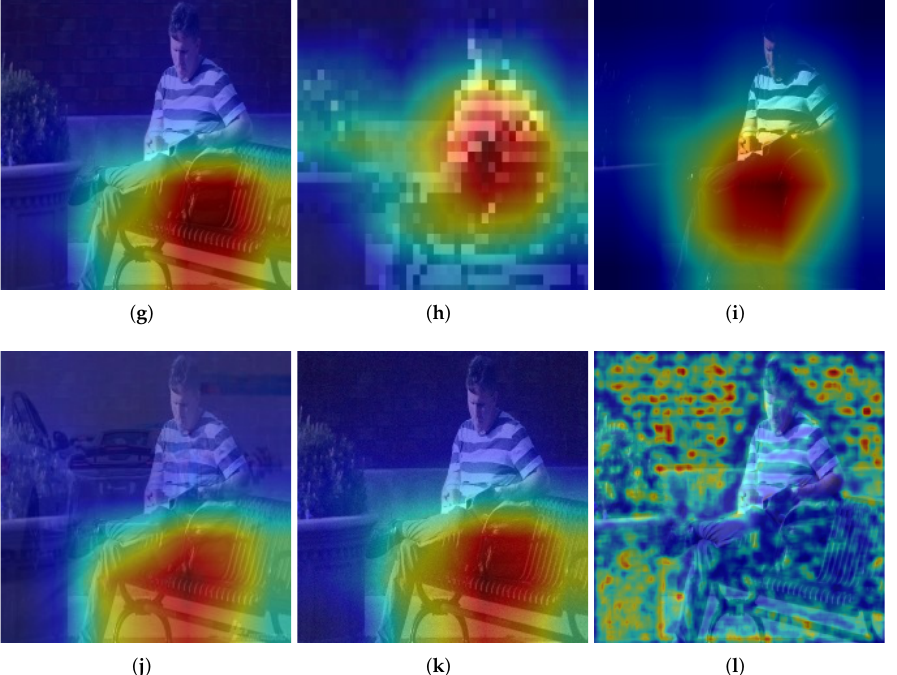
Figure 4. Examples generated by traditional methods and adversarial methods through the visual- ization method, including mosaic, brightness, transparency, noise, and adversarial attack. We set up Resnet50 and Densenet161 as the backbone for constructing a deep hash network. The warmer colors in the examples indicate the attention of the deep neural network has been attracted. ( a ) Original (Resnet50); ( b ) mosaic (Resnet50); ( c ) brightness (Resnet50); ( d ) transparency (Resnet50); ( e ) noise (Resnet50); ( f ) adversarial example (Resnet50); ( g ) original (Densenet161); ( h ) mosaic (Densenet161); ( i ) brightness (Densenet161); ( j ) transparency (Densenet161); ( k ) noise (Densenet161); ( l ) adversarial example